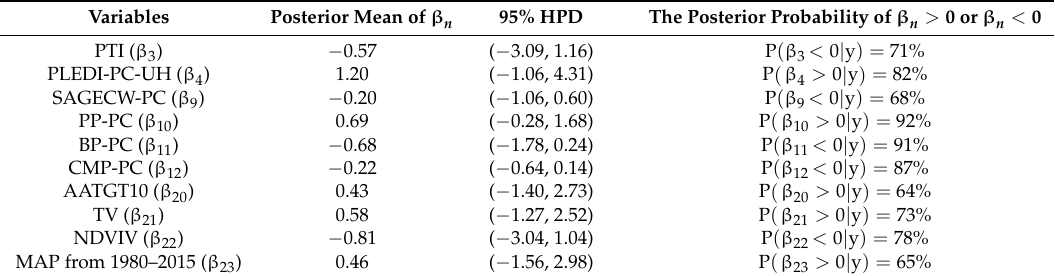
Table 2. The Bayesian Lasso regression results of the 10 significant influencing factors. Variables Posterior Mean of β